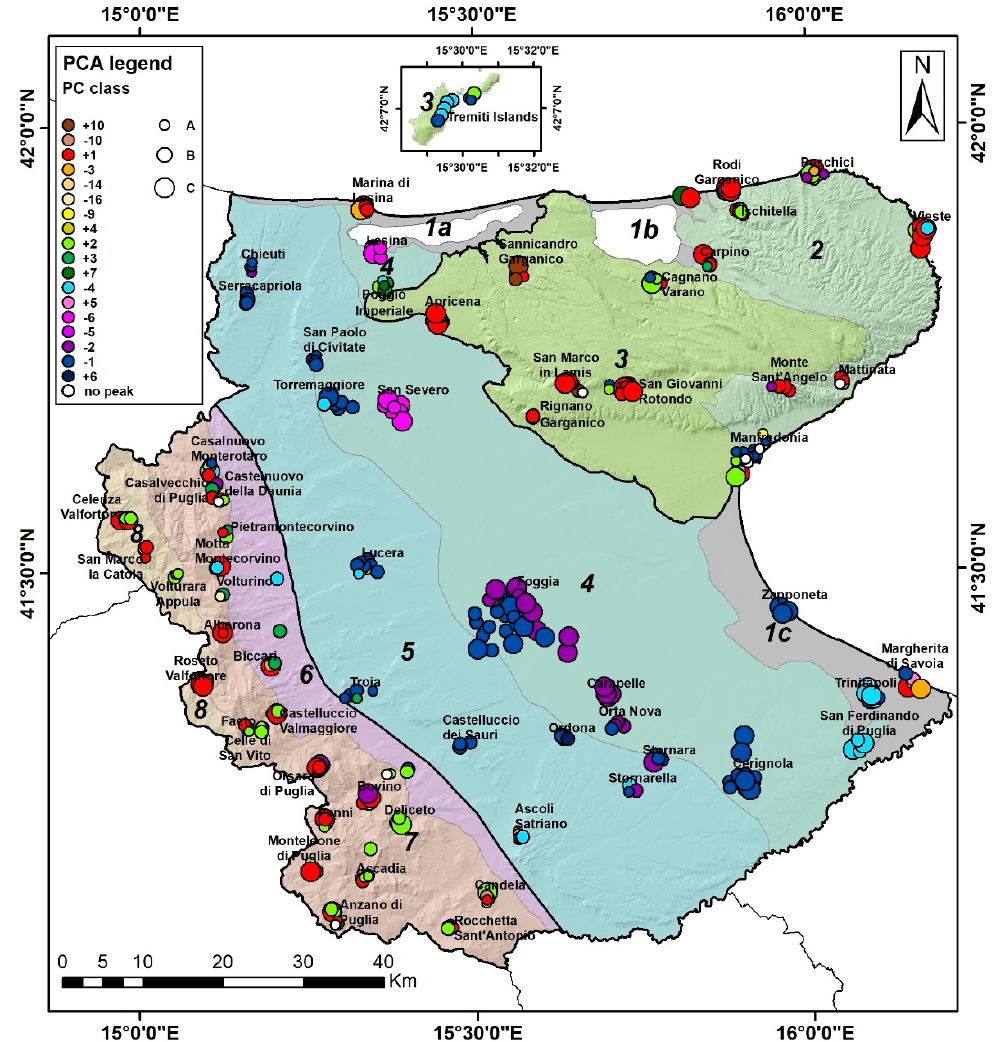
Figure 8. The dots in the map represent the locations of the single-station HVSR measurements, superimposed over the morphostructural domains (defined by the thick black lines) and respective subdomains (defined by colored polygons and respective representative codes) constituting the study area. The PC classes and their corresponding amplitude subclasses (A, B and C) are indicated by the color and size of the dots, respectively. In the PCA legend, the PC class names are sorted in descending order with respect to their fundamental resonance frequency (F 0 ).